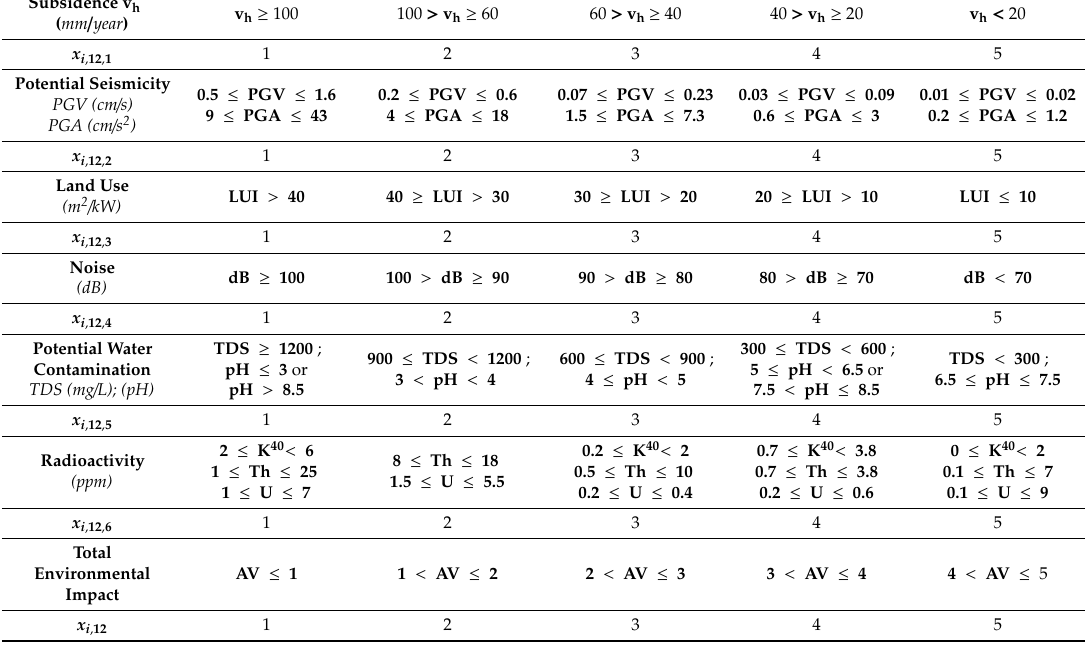
Table 12. Performance values x i ,12,j for 12th criterion are defined according to values available in References